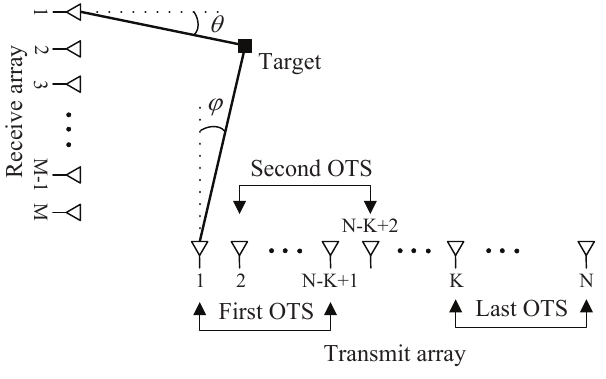
Figure 1. Multi-overlapped-transmit-subarray configured bistatic multiple-input multiple-output (MOTS MIMO) radar